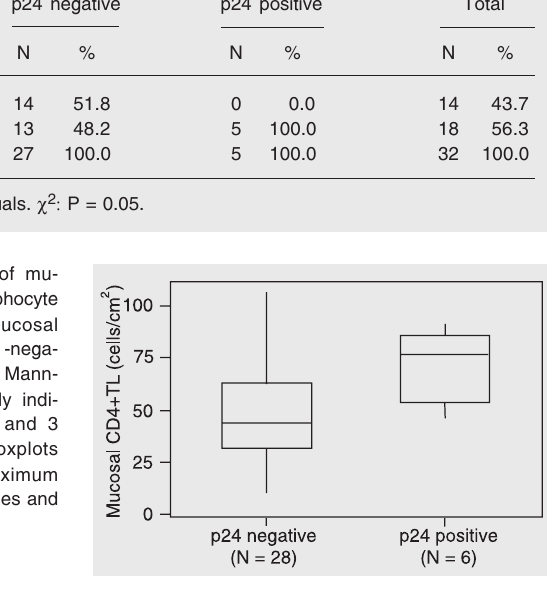
Table 6. IL-4 positivity in duodenal mucosa of patients with and without mucosal p24. Cytokine